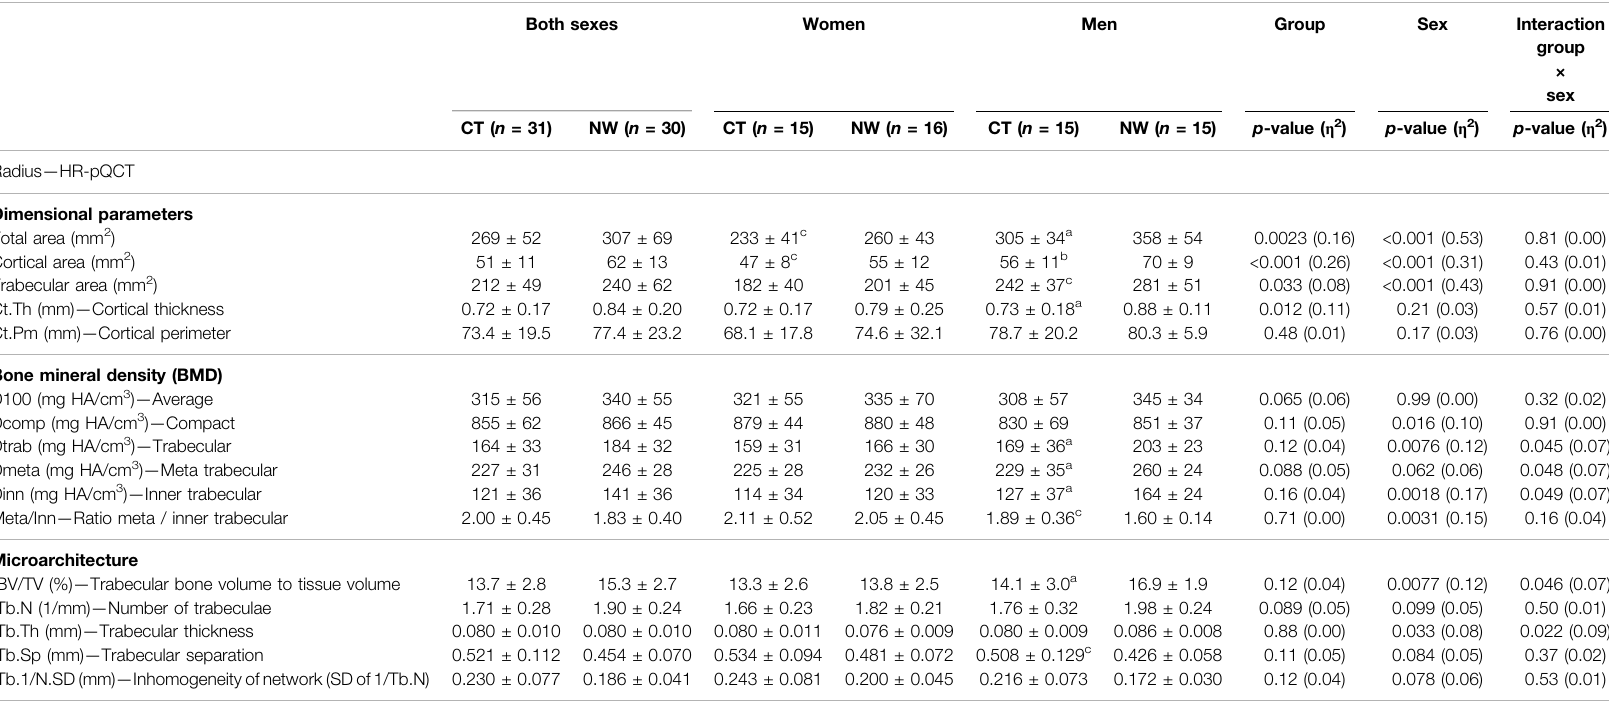
TABLE 3 | Bone architecture parameters of the distal radius assessed using high resolution peripheral quantitative computed tomography in women and men with constitutional thinness compared with normal weight participants. Both sexes